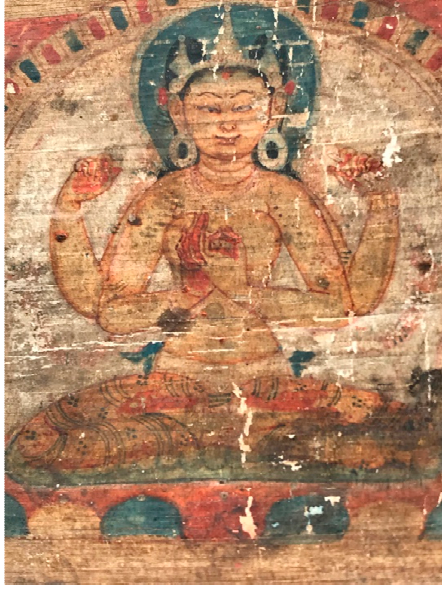
Figure 2. Prajñ ā p ā ramit ā , detail of fol. 1v. Perfection of Wisdom in Eight Thousand Lines: A ṣṭ as ā hasrik ā Prajñ ā p ā ramit ā -s ū tra , 1119. Nepal. Gum tempera and ink on palm leaf. 4.3 × 5.3 cm. Cleveland Museum of Art, purchase from the J. H. Wade Fund, 1938.301.